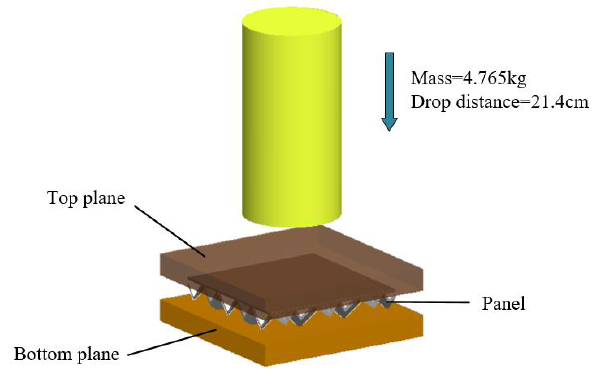
/ 4). Figure 10. Impact model of the panel (OL-3-3/4).